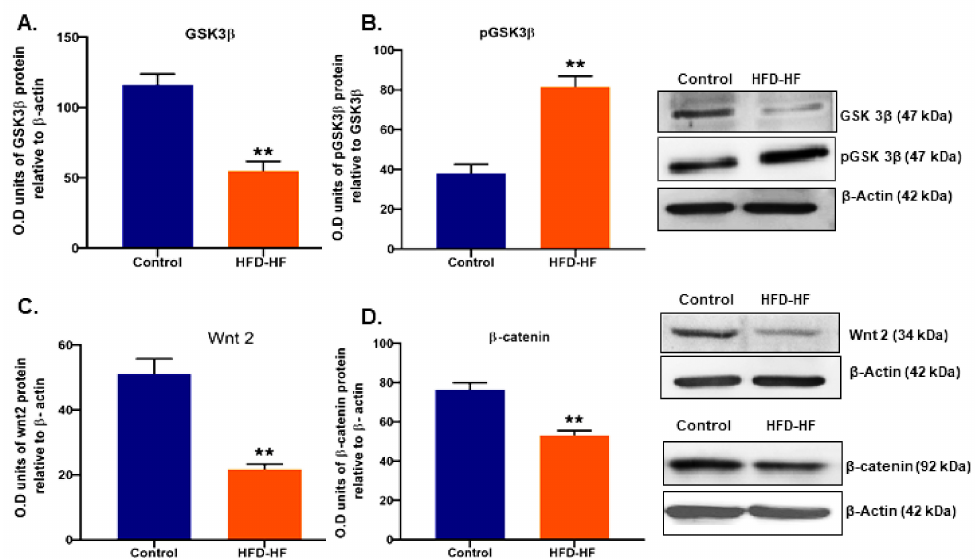
Figure 7. Effects of the HFD-HF diet on the expression level of ( A ) GSK3 β , ( B ) pGSK3 β , ( C ) Wnt2, and ( D ) β -catenin in the ovaries of adult rats. Each value is mean ± SEM of the three samples of pooled cells from six animals from each group. Bars with (**) signs represent statistically significant differences (** p ≤ 0.01 vs. control) group between the respective means.